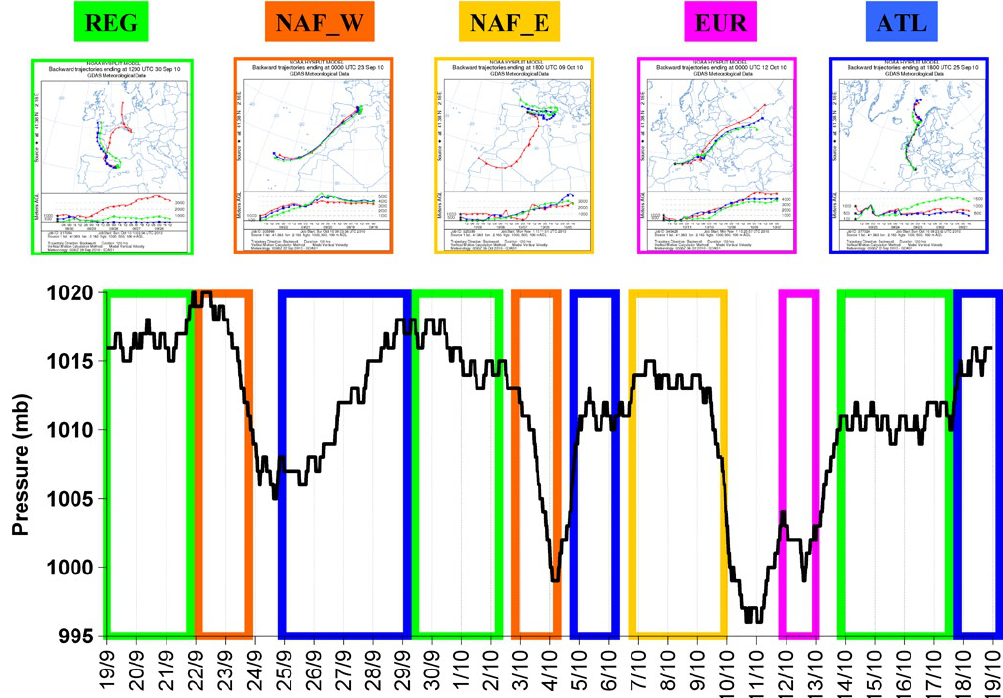
Fig. 3. Atmospheric pressure (mb) and temporal trend of air mass origins during